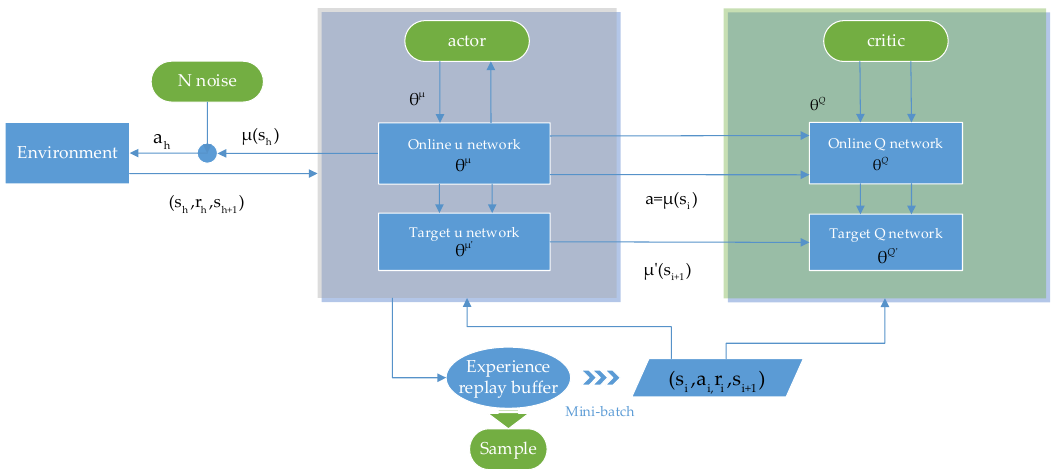
8 of 20 Figure 3. The overall diagram of the proposed decision-making process with deep deterministic policy gradient (DDPG) algorithm. B.